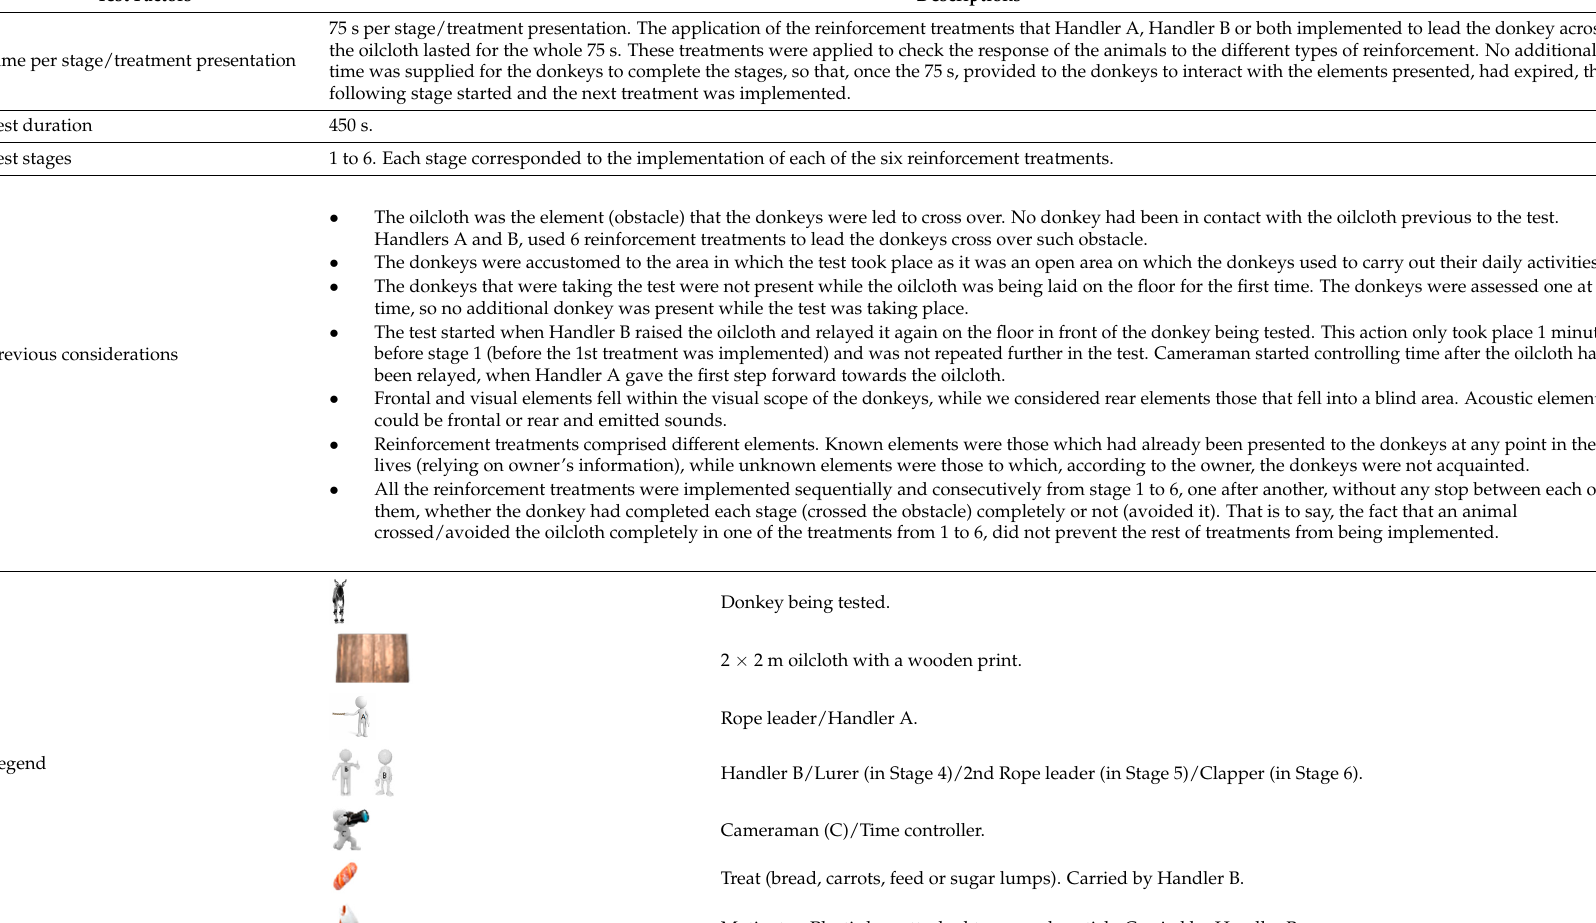
Table 1. Description of the operant conditioning test used in the study.